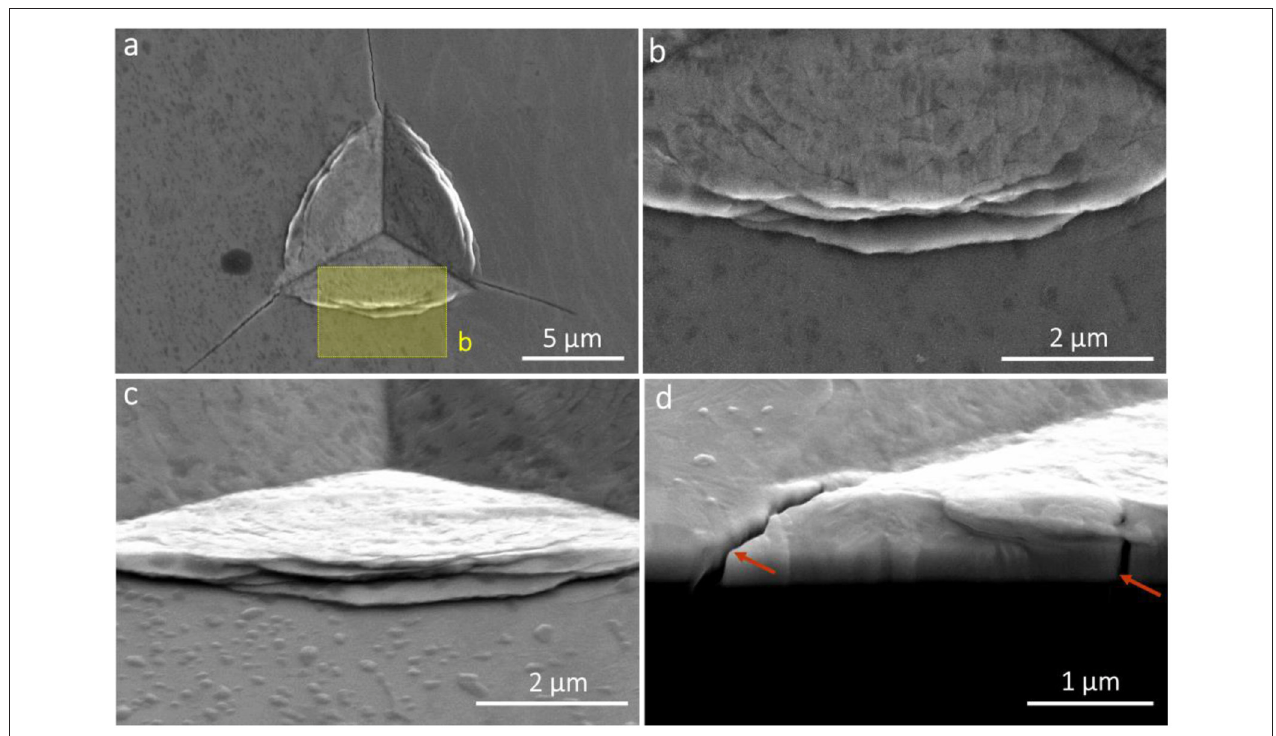
FIGURE 6 | SEM images of nanoindentation induced cracking at an applied load of 500 mN. Representative SEM images: plan-view (a) , close-up view of stacked layers (b) , indentation at 52 ◦ tilt (c) , and cross-sectional SEM image (d) milled by FIB for the nanoindentation induced cracking at a penetration load of 500